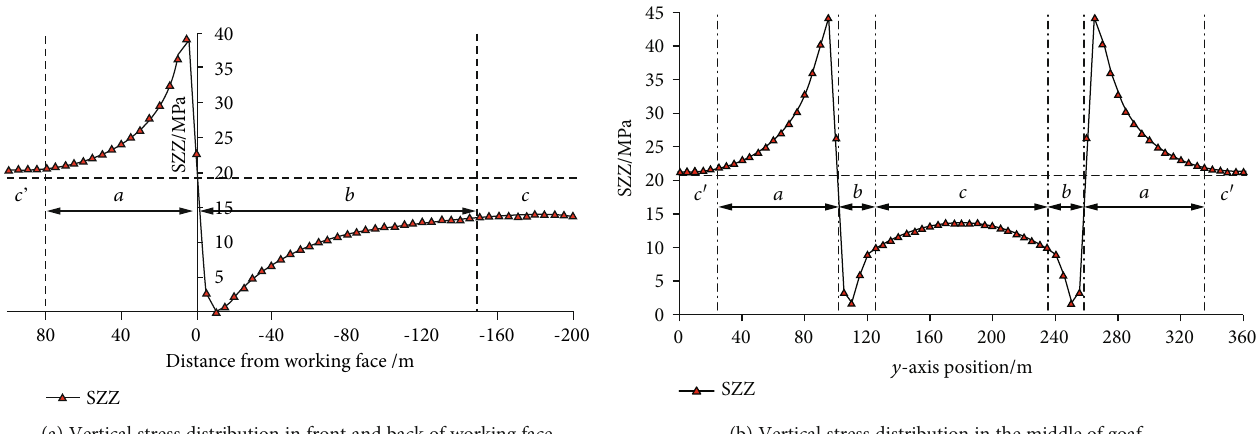
(b) Vertical stress distribution in the middle of goaf Figure 7: Abutment pressure distribution at monitoring line.